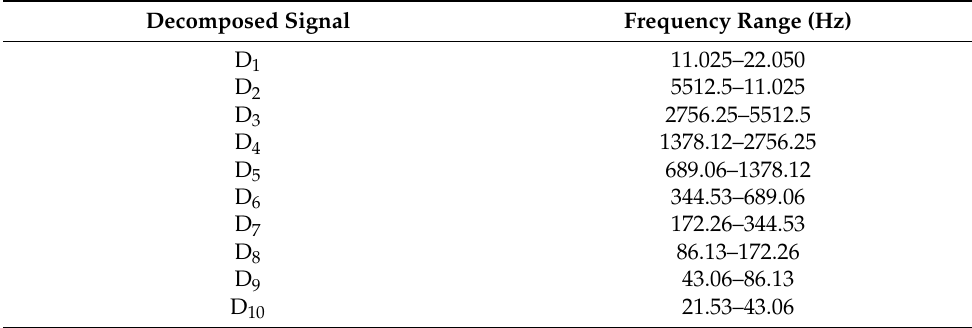
Figure 10. FFT of the engine in neutral and in normal conditions. Table 1. Range of frequency bands in wavelet